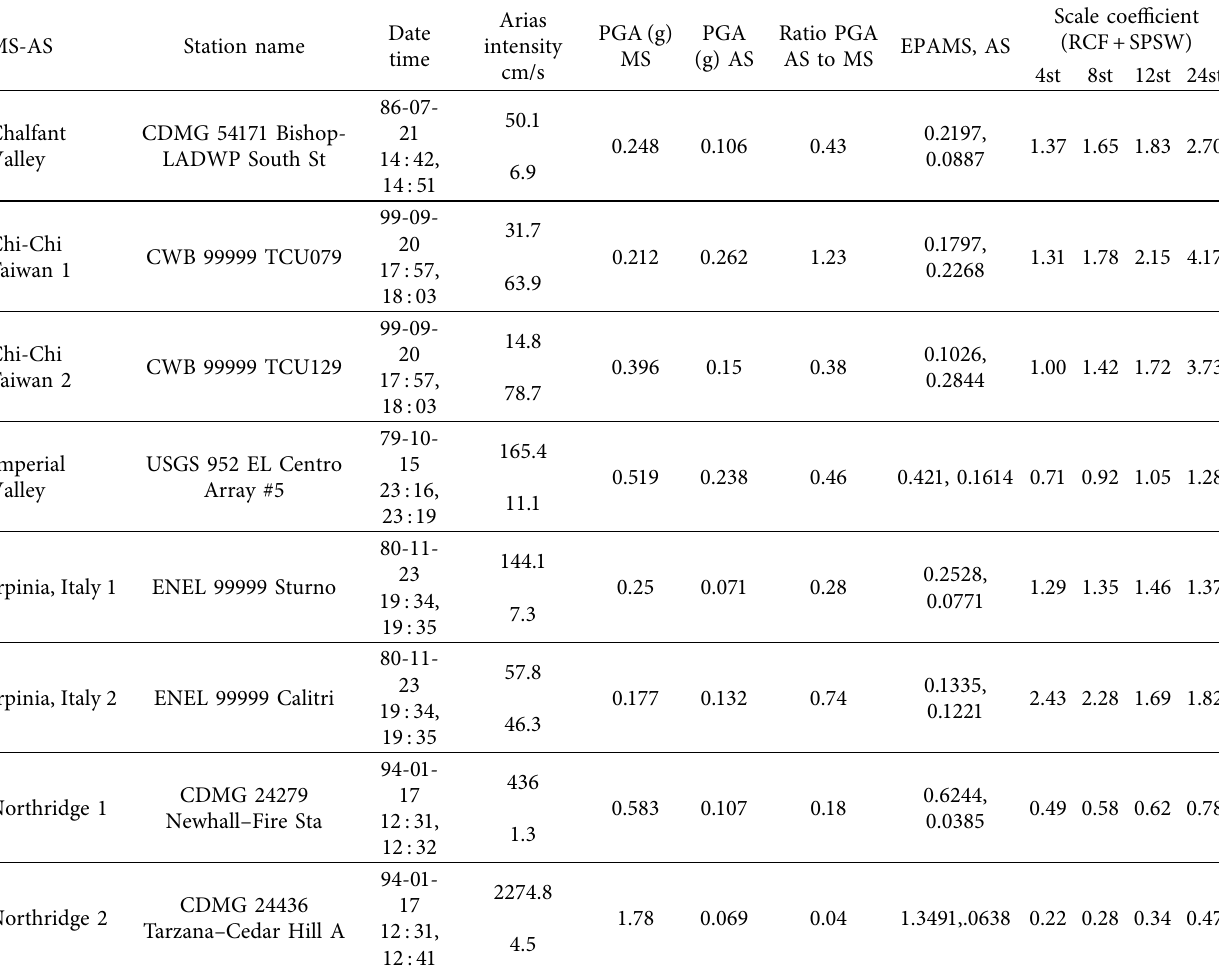
Table 11: Result for scaling the second category of seismic scenario (with nearly maximum EPA).